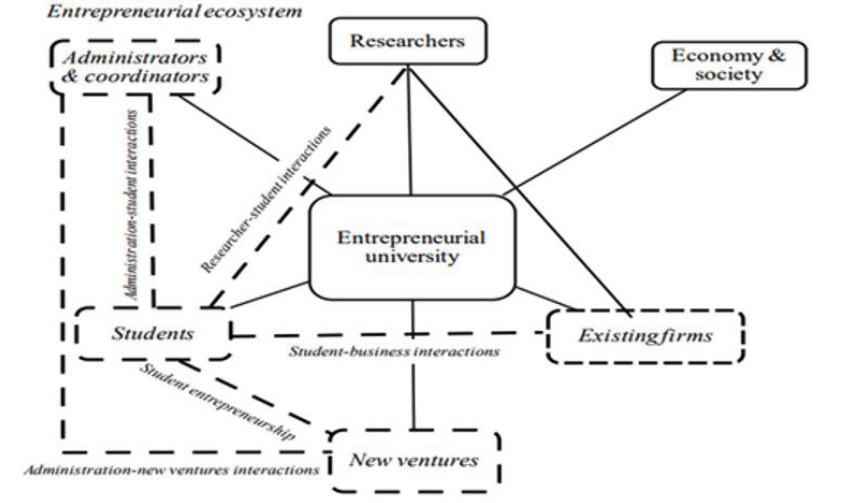
Figure 1: An entrepreneurial university ecosystem; Source: Clauss, Moussa, & Kesting, 2018 Entrepreneurial